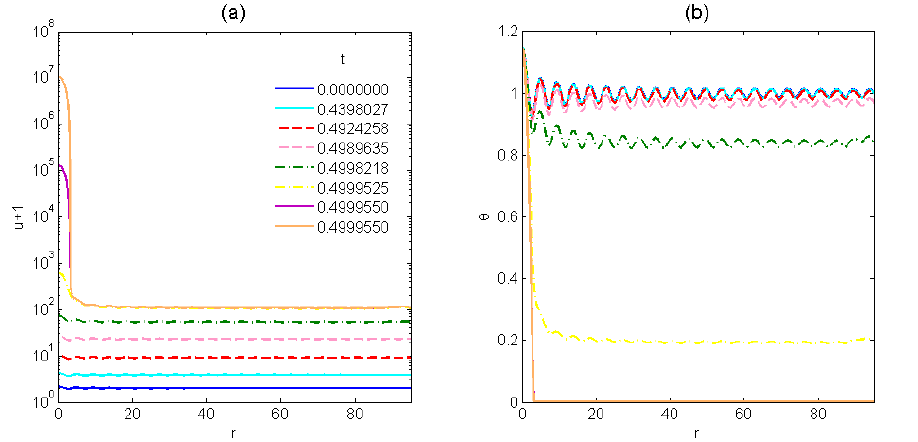
Figure 2. Evolution in time of the self-similar solution u